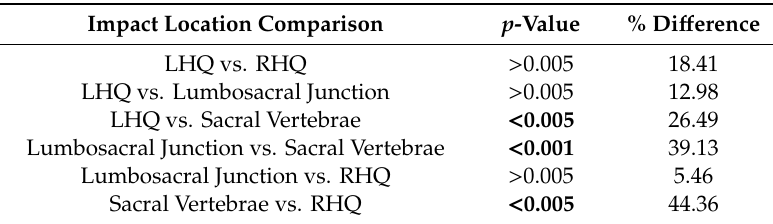
Table 5. Pooled peak load comparisons for all impact locations. p -Values in bold indicate statistically significant di ff erences. LHQ and RHQ denote left and right hind quarters,